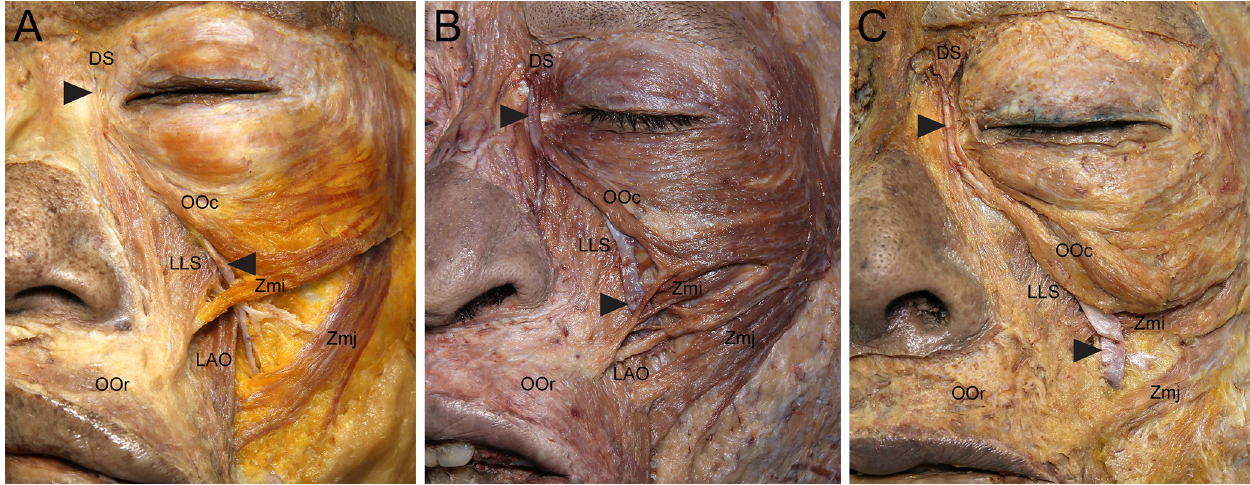
Fig 3. Course of the angular vein (arrowheads) in relation to the Zmi, LLS, and Zmj in the midface. At the level of the nasal ala, the angular vein passed between the LLS and Zmi (A), between the superficial and deep Zmi fibers (B), or between the Zmi and Zmj (C). LAO, levator anguli oris.